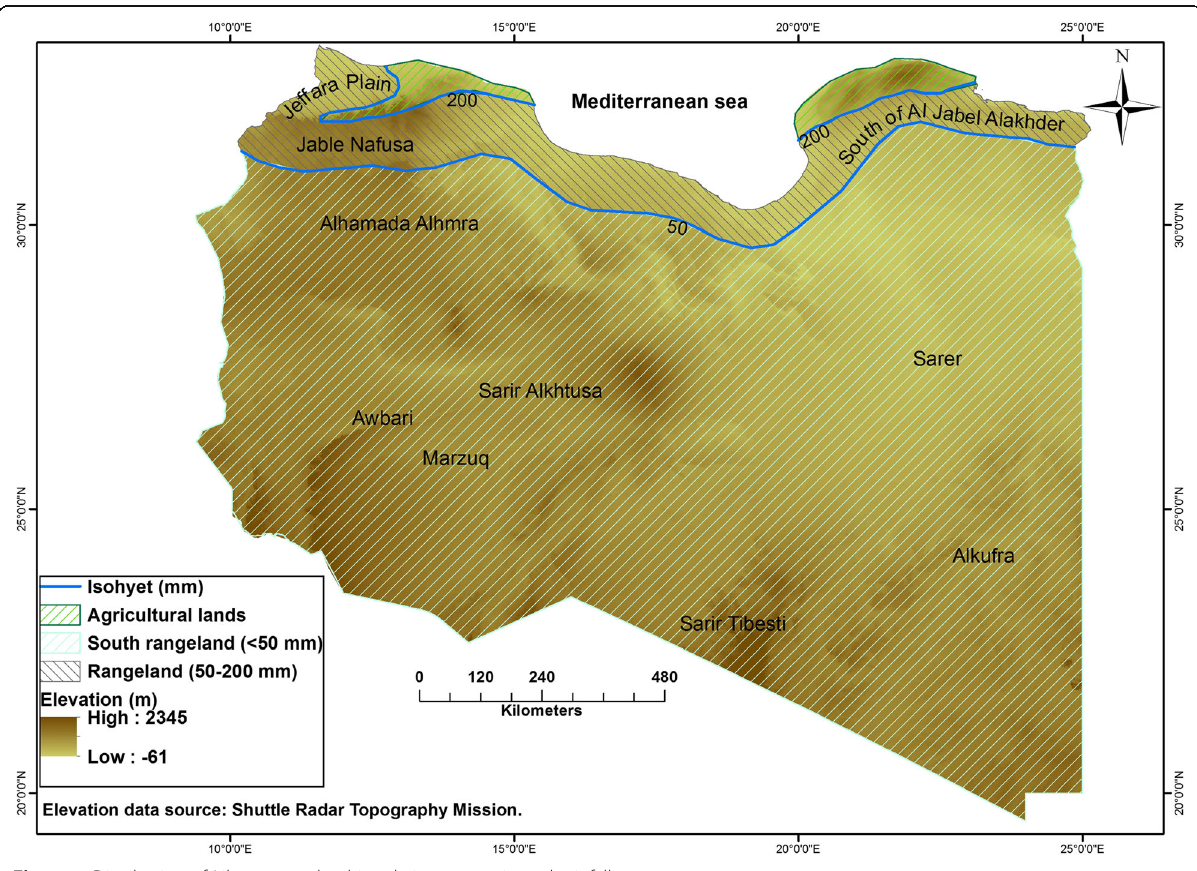
Figure 1 Distribution of Libyan rangeland in relation to terrain and